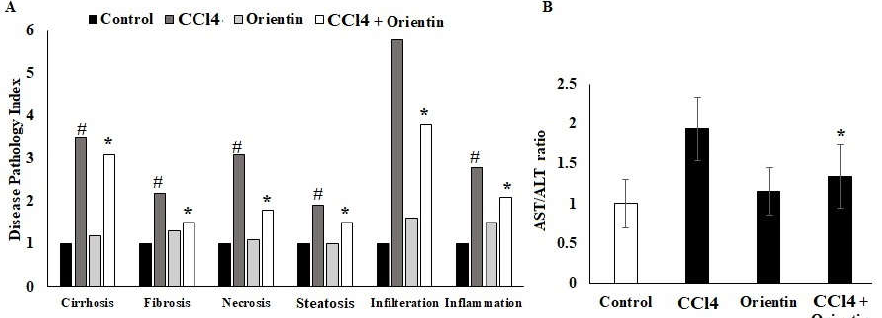
Figure 2. Effect of orientin on liver. ( A ) The disease pathology scores for liver injury. ( B ) Effect of orientin on CCl 4 -induced changes in hepatic functional markers of ALT activity and AST activity. Orientin-treated liver tissues were excised after the 7th day of ip injection and homogenate using ice cold PBS. All values are expressed as mean ± SD. * Represents the significant comparison with the control. # Represents the significant comparison with control and CCl 4 -induced